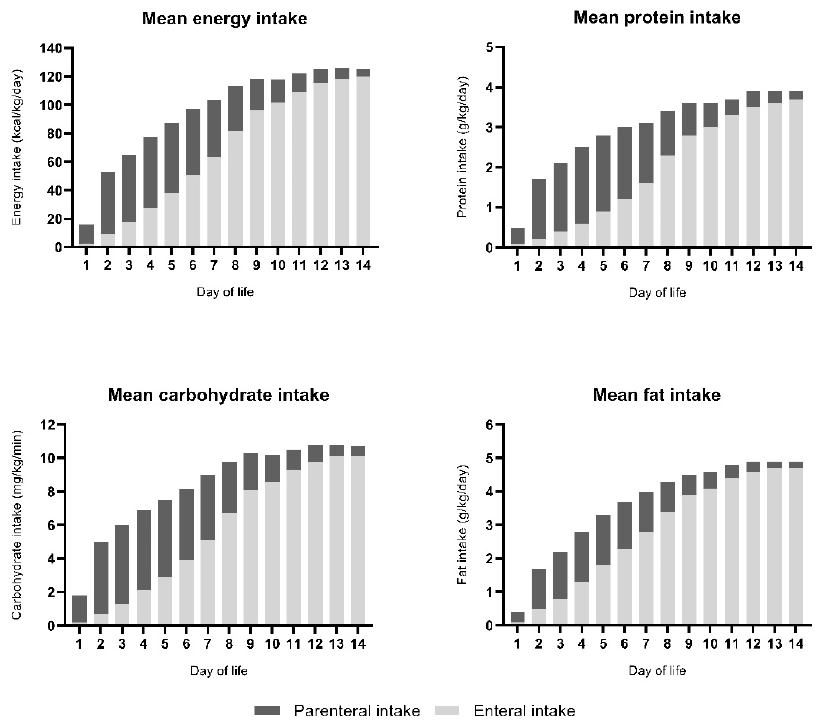
Figure 4. Parenteral and enteral nutrient intake in preterm infants in the first two weeks of life.